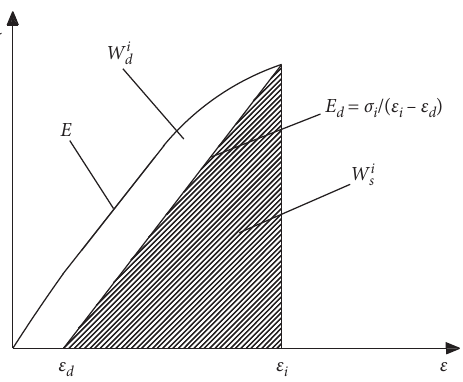
Figure 4: Relationship between elastic strain energy and dissipative energy in the coal and the rock